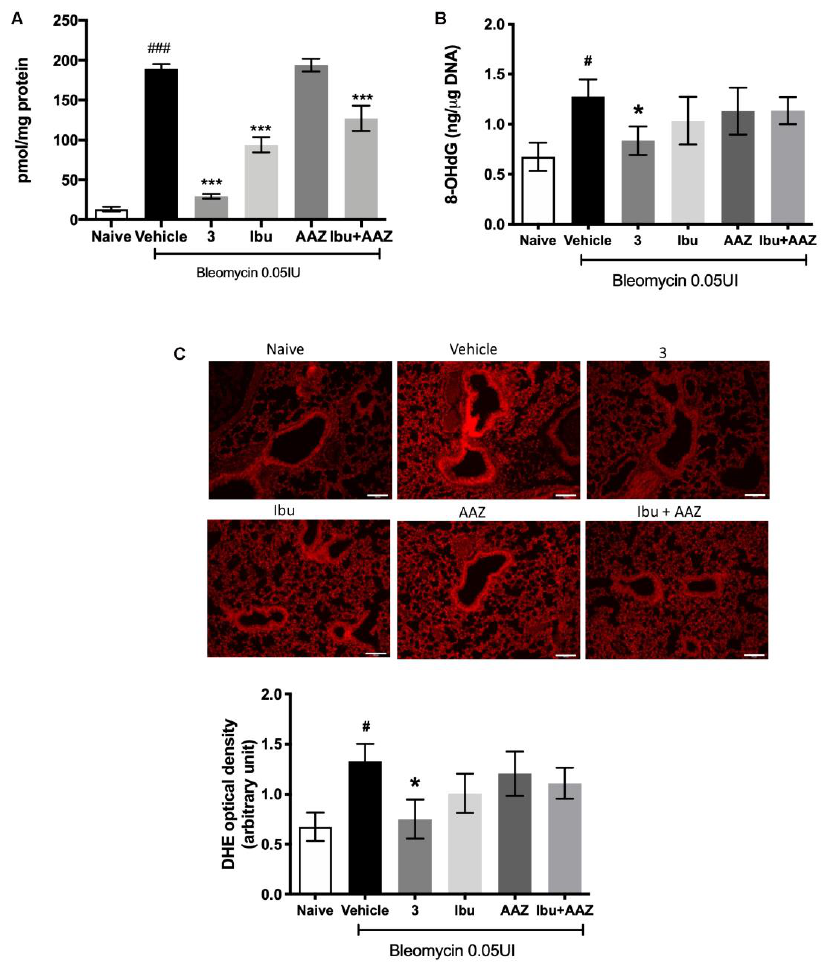
Figure 8. Evaluation of oxidative stress parameter in lung tissue. ( A ) Levels of myeloperoxidase (MPO), a marker for leukocyte accumulation in inflamed tissues. ( B ) Levels of 8-OH d G, a marker of free radicals-induced DNA damage; ( C ) dihydroethidium (DHE), a morphological marker of DNA damage and the densitometer evaluation. n = 6 animals / group. Values are mean ± SEM. # p < 0.05 vs. Naive. ### p < 0.001 vs. Naive. * p < 0.05 vs. Vehicle. *** p < 0.001 vs. Vehicle. Scale bar, 100 µ